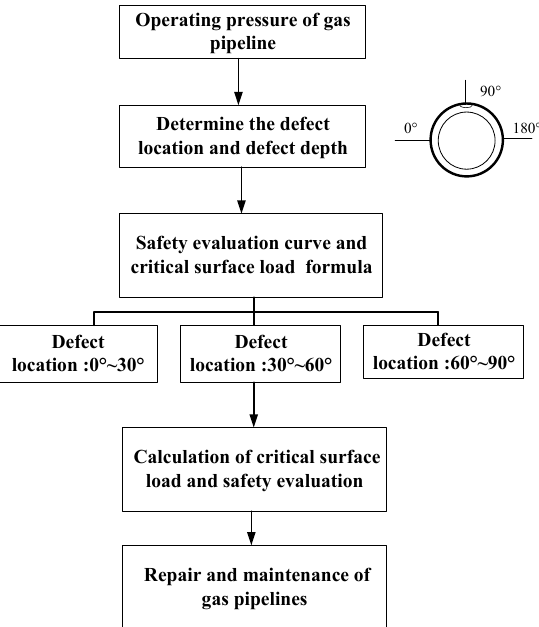
Figure 30. Fitness-for-service assessment method for pipes with defects.